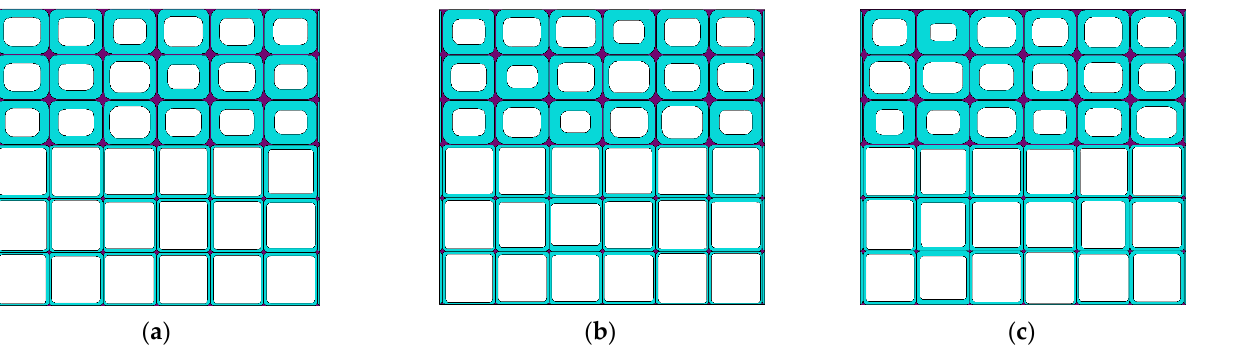
Figure 3. Generated FE models with random cell wall thicknesses: ( a ) Model 1; ( b ) Model 2; ( c ) Model 3.